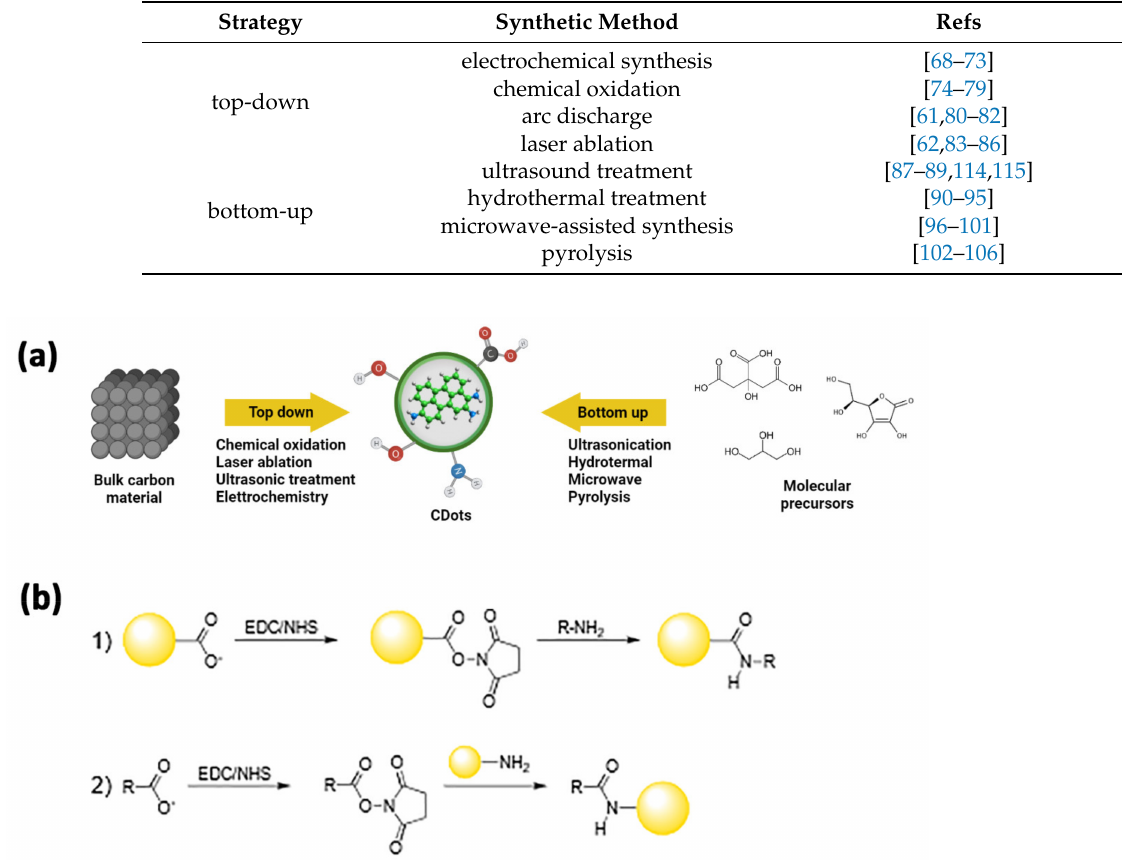
Table 1. Synthetic approaches to the production of C-dots.